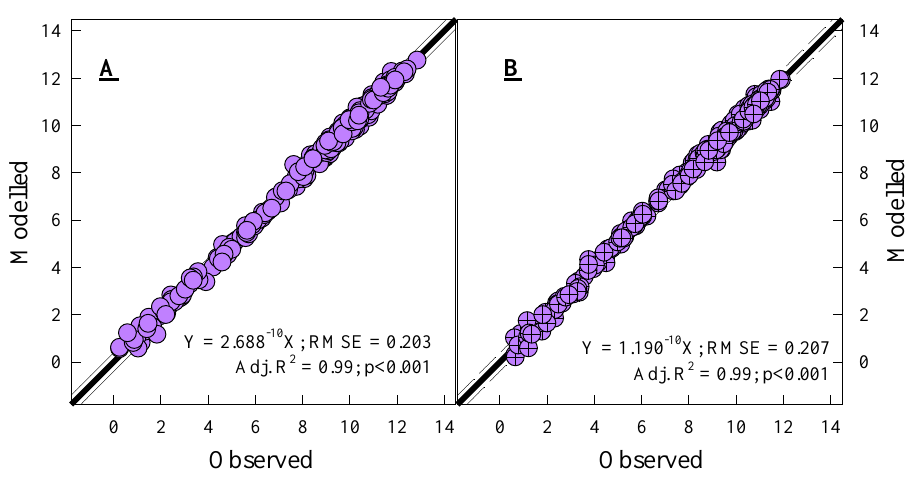
Figure 6. Daily pond temperatures for the three different BDA configurations over the 2019 post-BDA installation pe- riod.